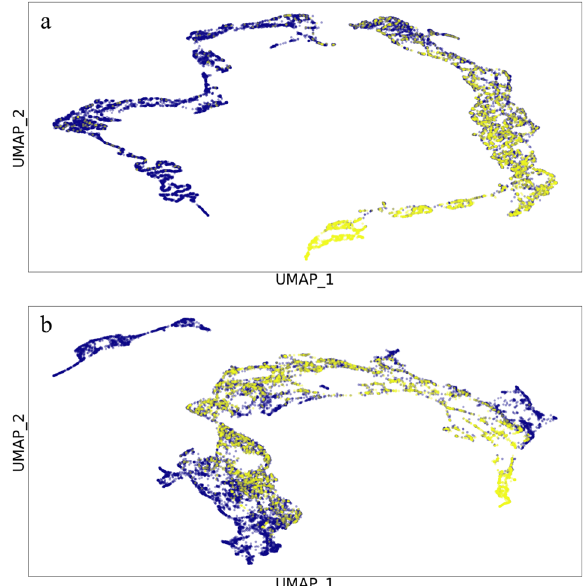
Fig. 4 Visualization of learned rhythm class distinction. UMAP representation from the last (Dense_18) layer of the DeepBeat model. The two colors represent the two classes, respectively, normal sinus rhythm as purple, and yellow as atrial fi brillation. Top panel ( a ): pretrained network, bottom ( b ), random initialization. The distinction between the two classes is clear in the pretrained network compared to random